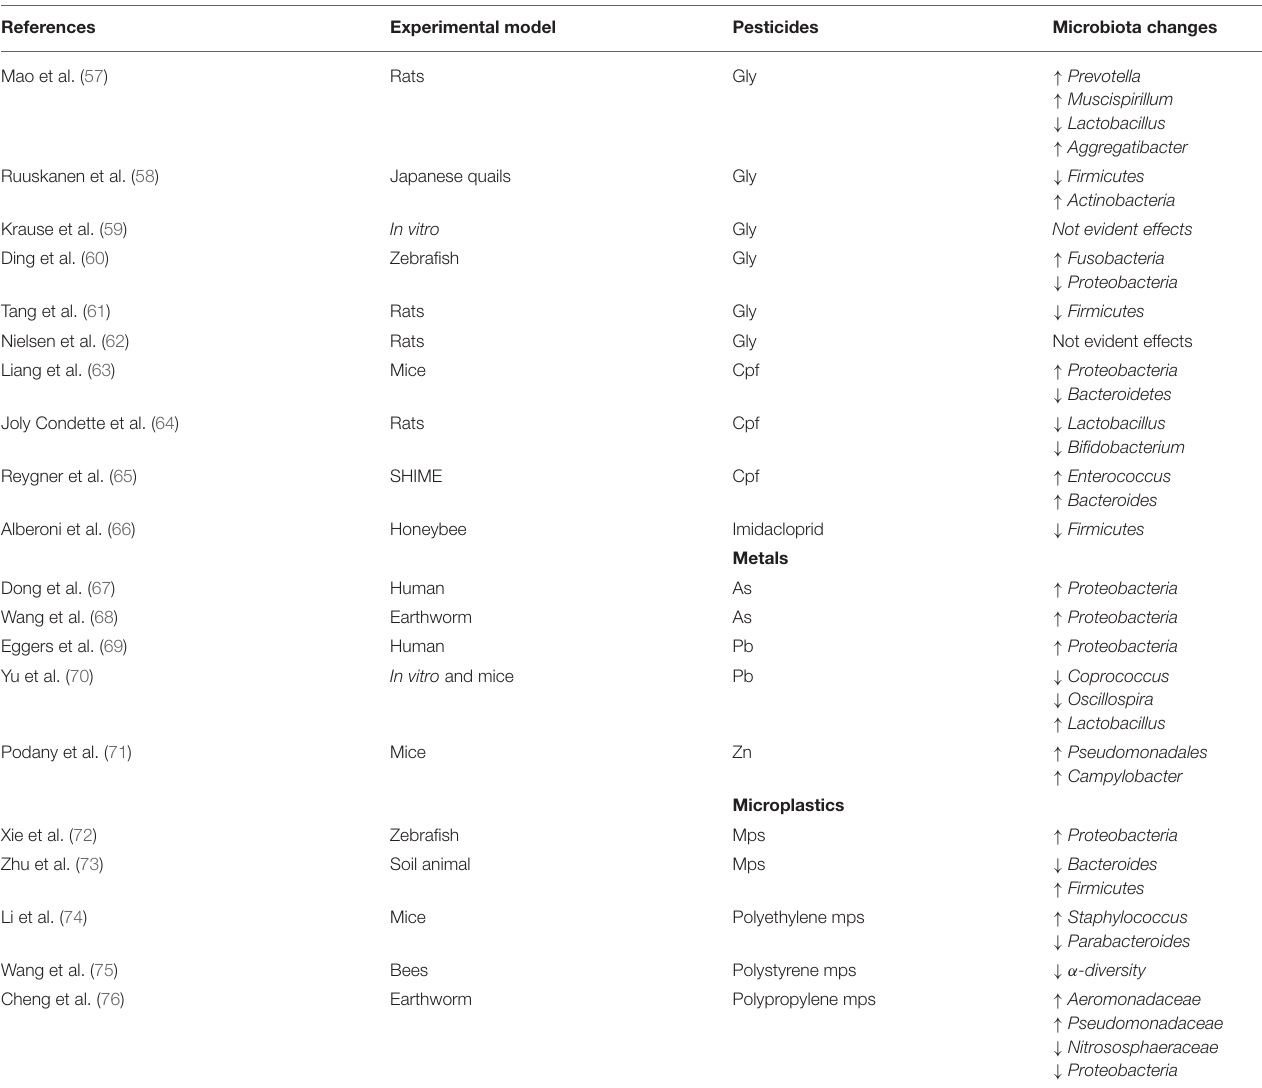
TABLE 1 | Main results of the studies included in this